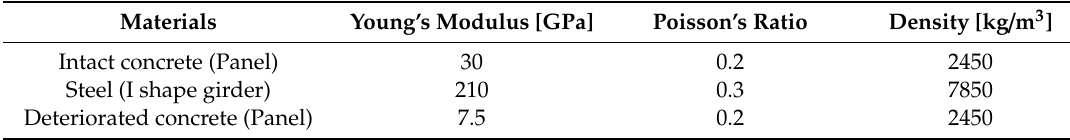
Table 2. Material properties in FEM for the slab model.